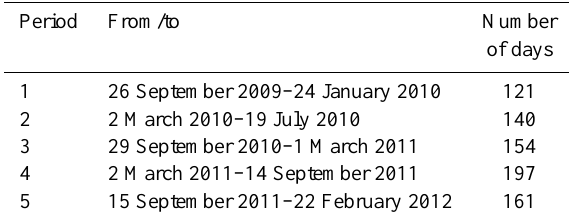
Table 1. Periods of available meteorological input for cross-